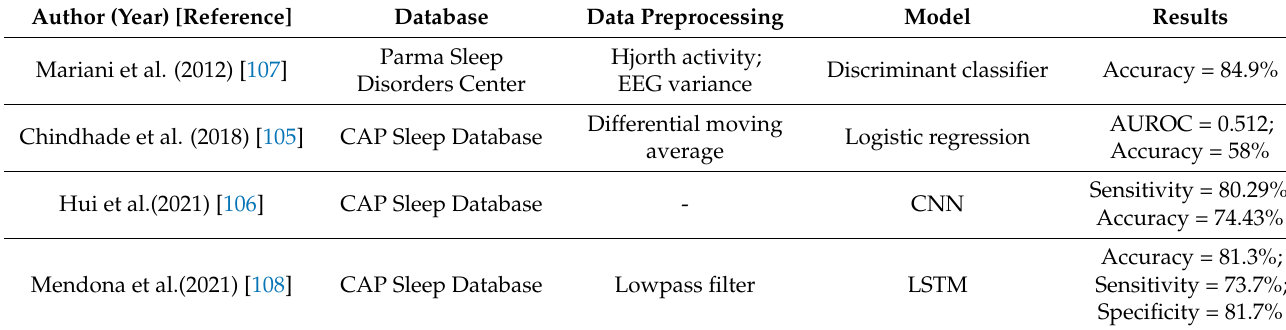
Table 10. Automated detection of